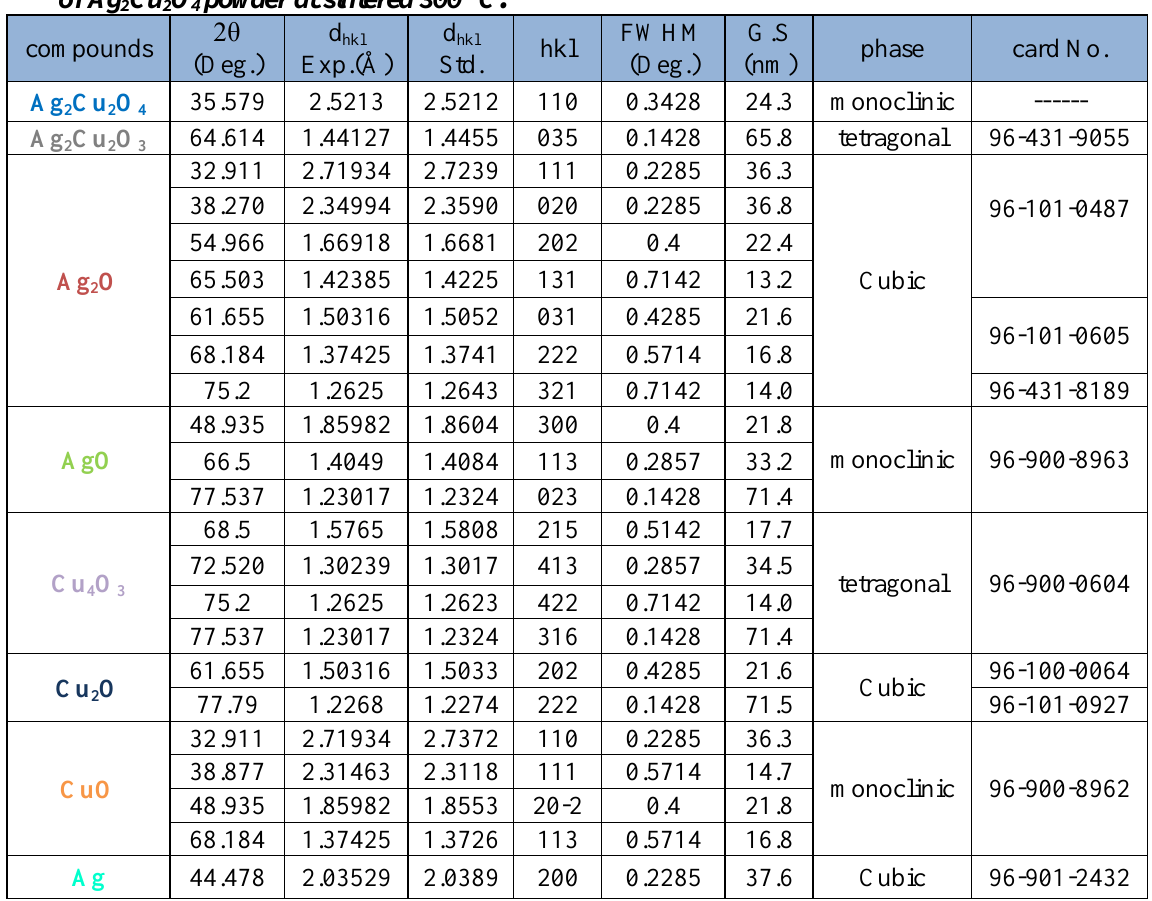
Table 2: Structural parameters viz. inter-planar spacing, crystallite size and Miller indices of Ag Cu O powder at sintered 300 °C. 2 2 4